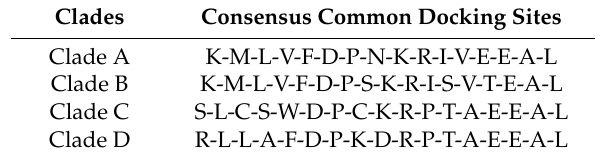
Table 3. Consensus common docking sites in the MPK proteins belonging to clades A–D.